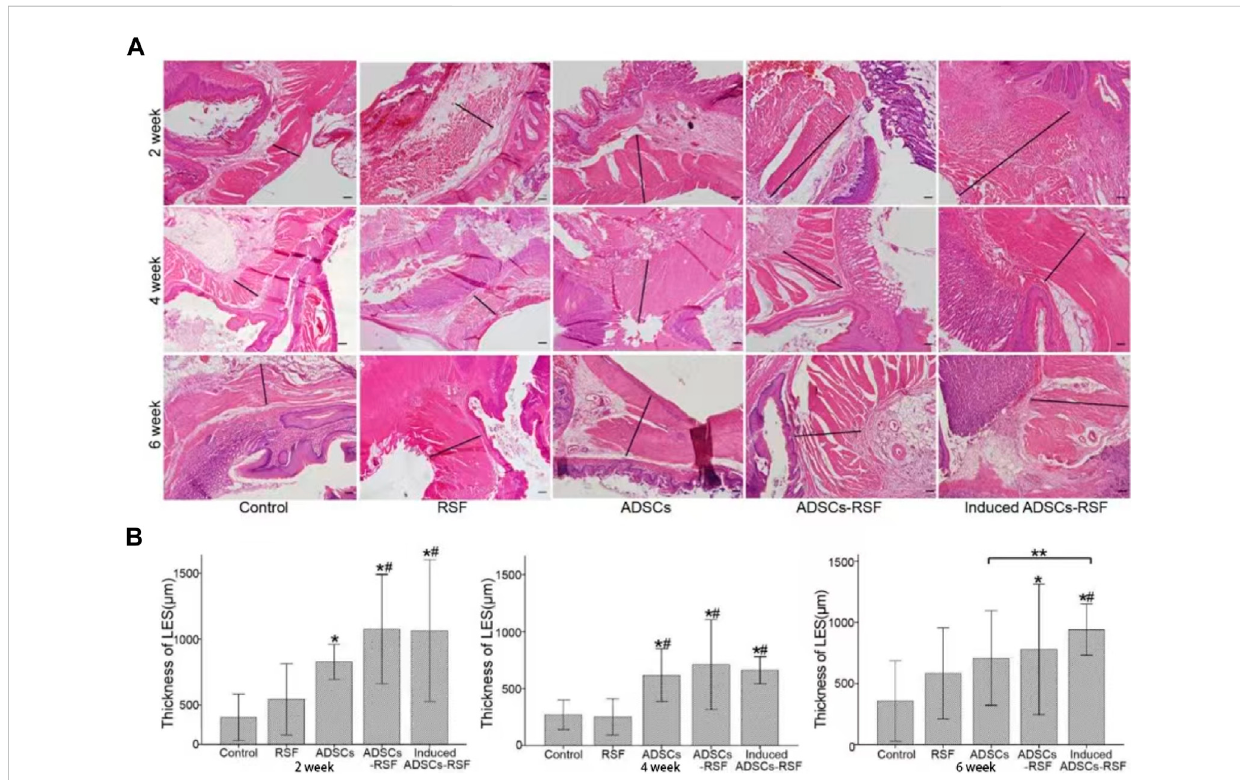
FIGURE 4 Establish gastroesophageal re fl uxrat models andtransplantPBS,RSF, ADSCs, ADSCs-RSF, andinducedADSCs-RSF into theloweresophagusofthe models separately. (A) HE staining showed the thickness of the lower esophagus sphincters (LES) measured at 2, 4, and 6 weeks after transplantation. (B) According to Statis data, compared with the control group and RSF group, the thickness of LES in the experimental groups increased signi fi cantly and more signi fi cantly in ADSCs-RSF and induced ADSCs-RSF group. Along with the time going on, compared with the ADSCs group, the thickness of LES in the induced ADSCs-RSF showed statistical differences at 6 weeks after transplantation. * Compared with the control group, the difference was statistically signi fi cant; # Compared with the RSF group, the difference was signi fi cant; ** The difference between the two groups was statistically sense. Scale bar = 200 μ